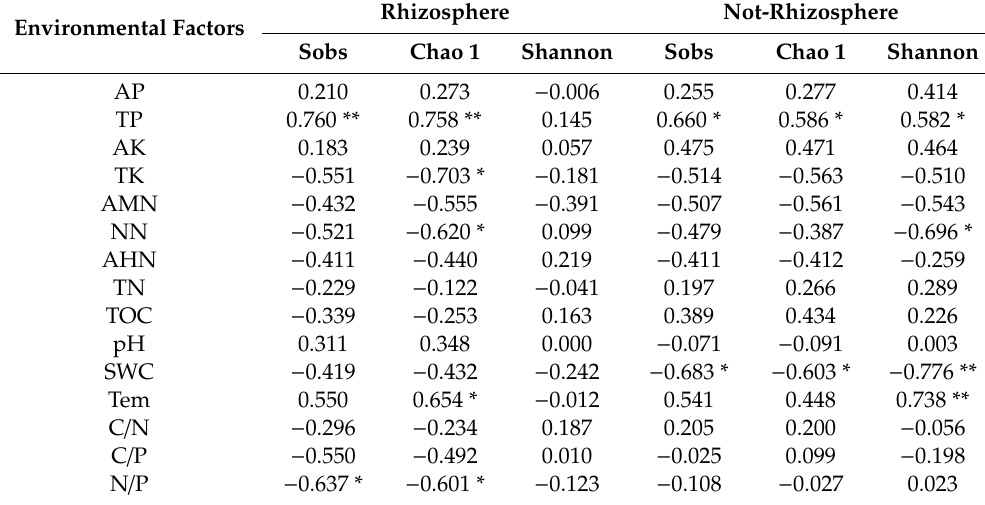
Table 3. Correlations between environmental factors and fungal alpha-diversity based on Pearson correlation coe ffi cients with the two-tail test at 0.05 (*) and 0.01 (**)